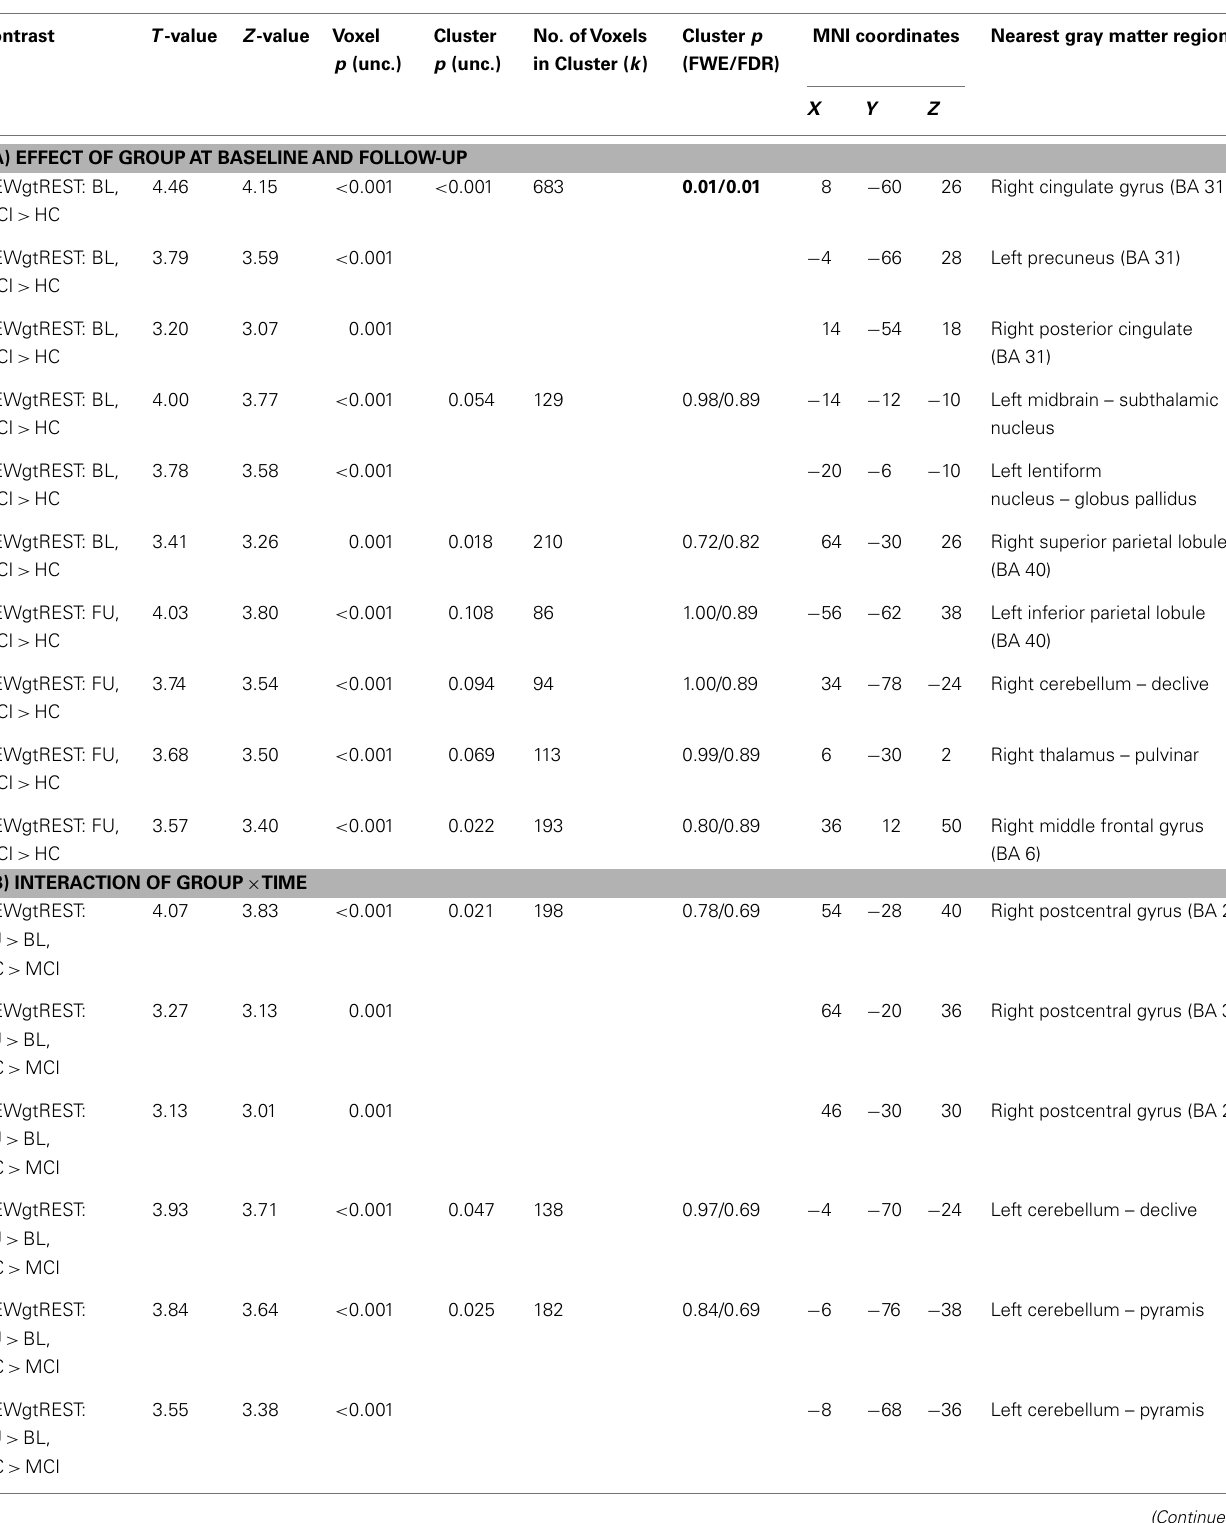
TableA2 | Brain activation during episodic memory encoding task (new >